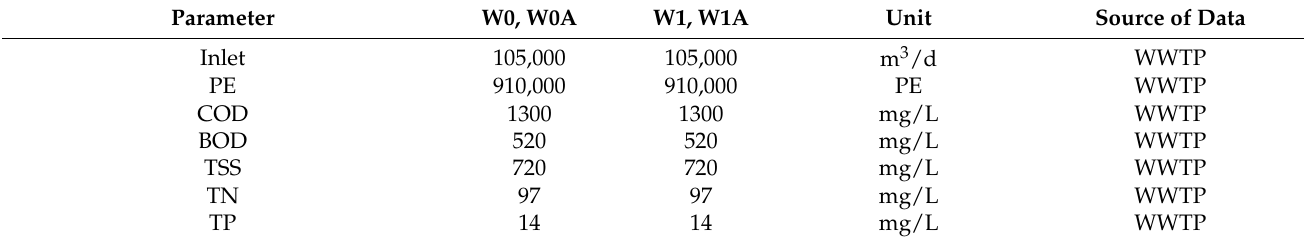
Table 1. Assumptions for mass and energy balance and economic